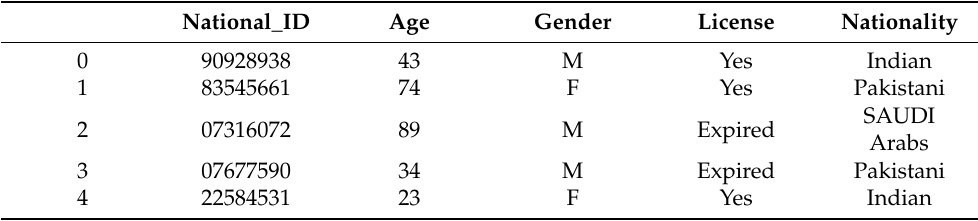
Table 2. Generated driver’s